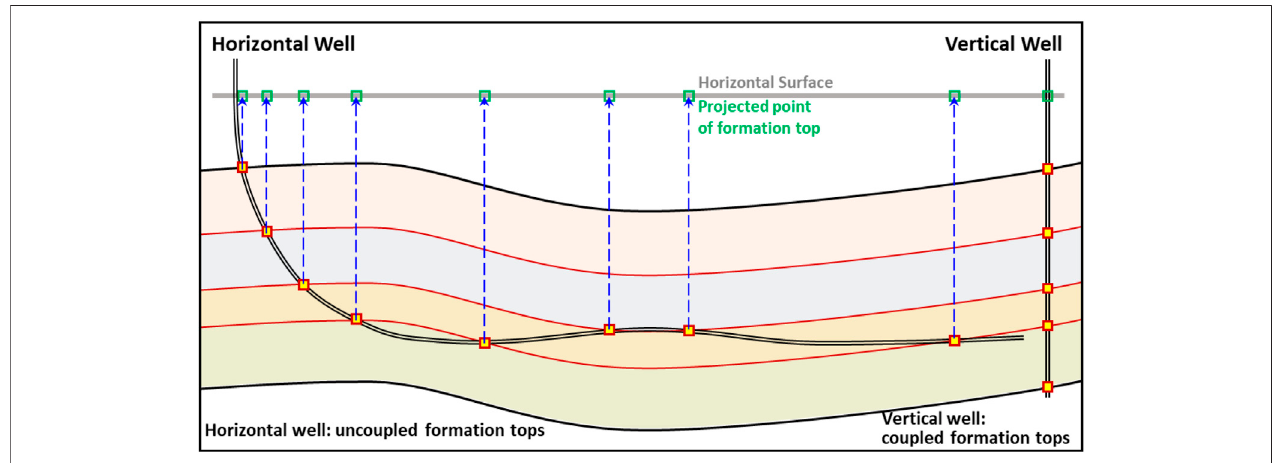
FIGURE 1 | Comparison of formation tops and wellbore trajectory characteristics in horizontal wells and vertical wells.